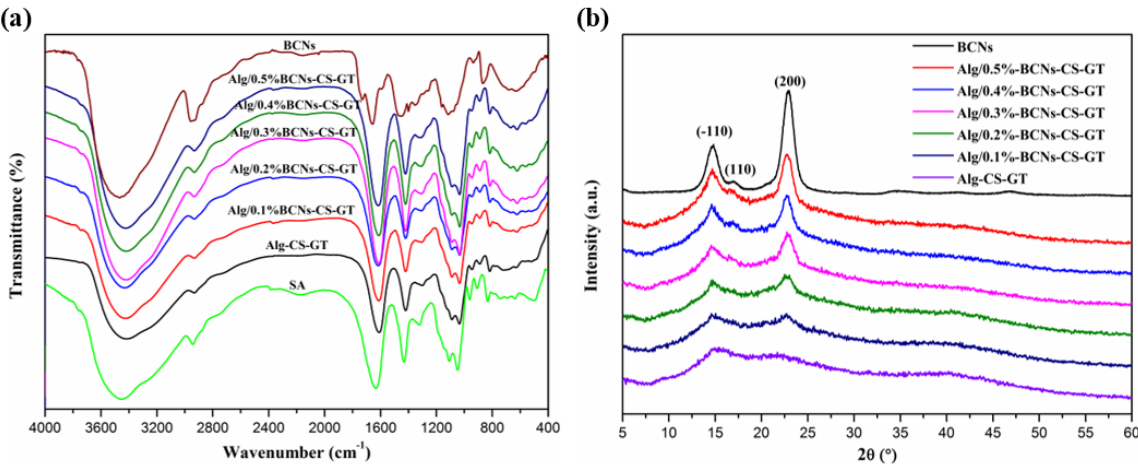
Figure 5. ( a ) FT-IR spectra and ( b ) XRD patterns of SA, BCNs, Alg-CS-GT and Alg/BCNs-CS-GT composite scaffolds. In addition, the XRD patterns of the SA, BCNs, Alg-CS-GT and